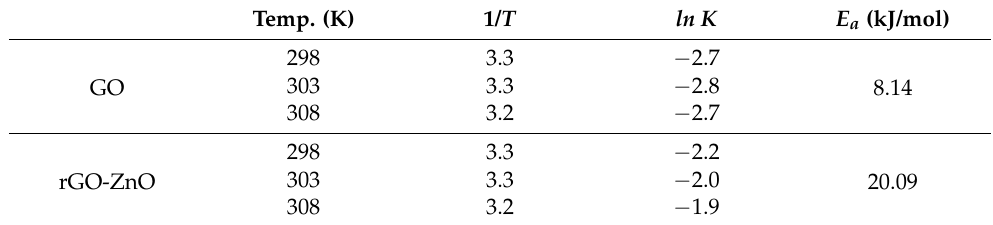
Table 4. E a obtained from the linearized Arrhenius equation. Temp. (K) 1/ T ln